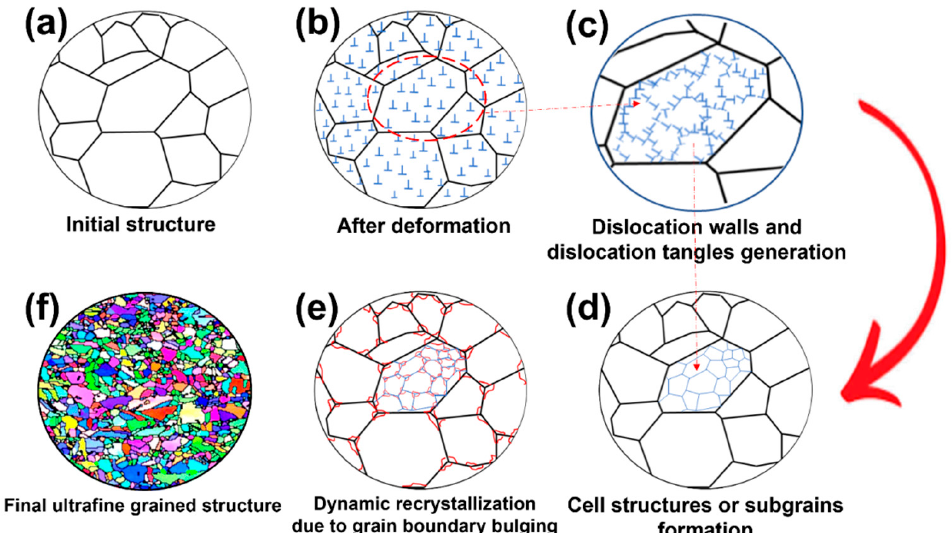
Figure 5. A schematical model for dislocation substructure and its evolution to final ultrafine-grained structure after CEC processing: ( a ) initial structure, ( b ) after deformation, ( c ) structure including dislocation walls and dislocation tangles, ( d ) cell structure and subgrain formation, ( e ) dynamic recrystallization and grain boundary bulging, and ( f ) an ultrafine-grained structure.